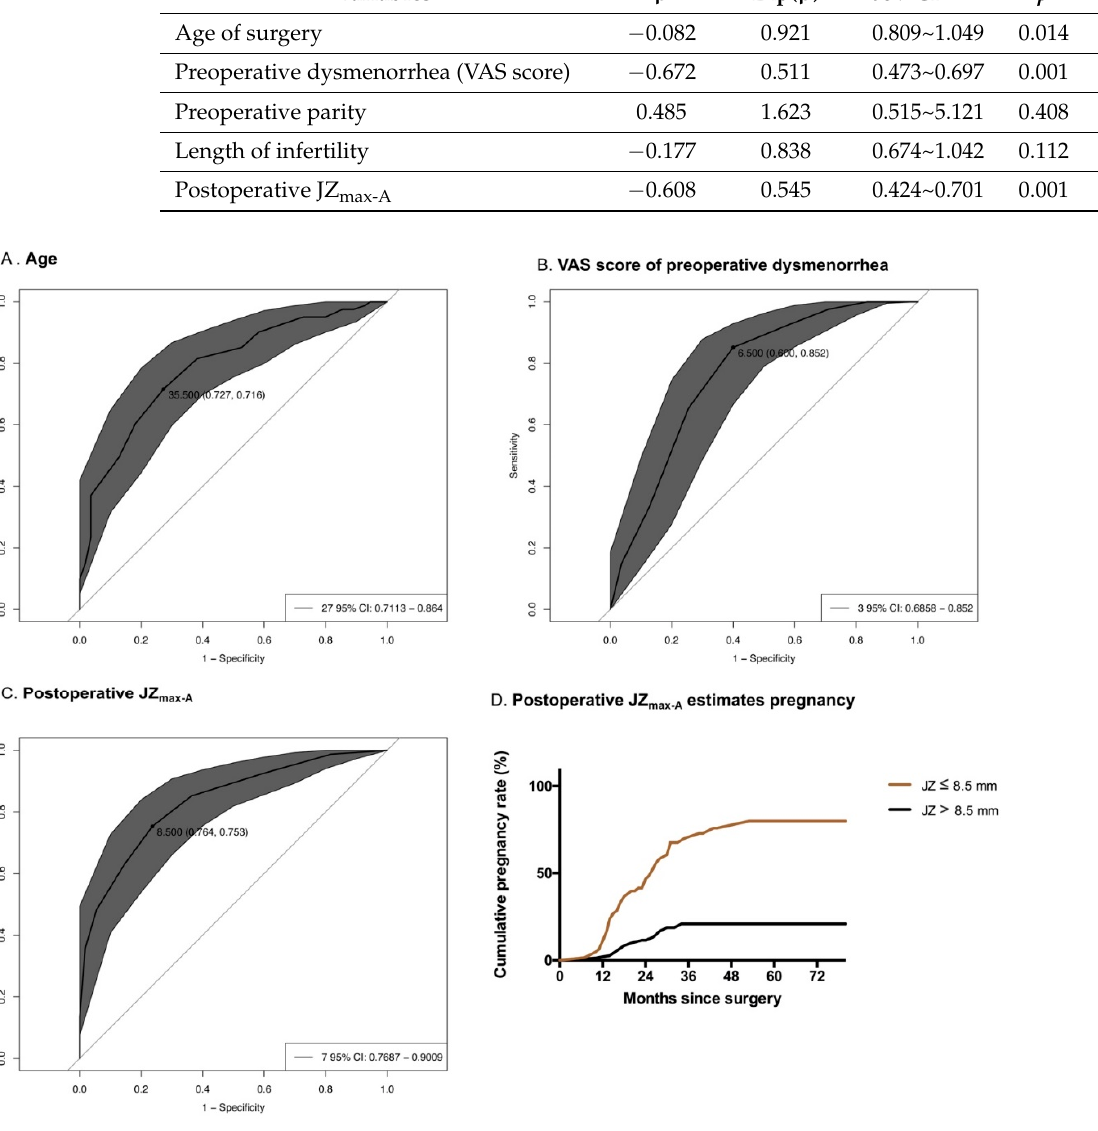
Figure 3. ( A – C ) ROC analysis for pregnancy prediction: ( A ) AUC of age at surgery = 0.791, p = 0.001; ( B ) AUC of the VAS score of preoperative dysmenorrhea = 0.773, p = 0.015; ( C ) AUC of postoperative JZ max-A = 0.836, p = 0.001; ( D ) Postoperative JZ max-A estimation of pregnancy. The K–M